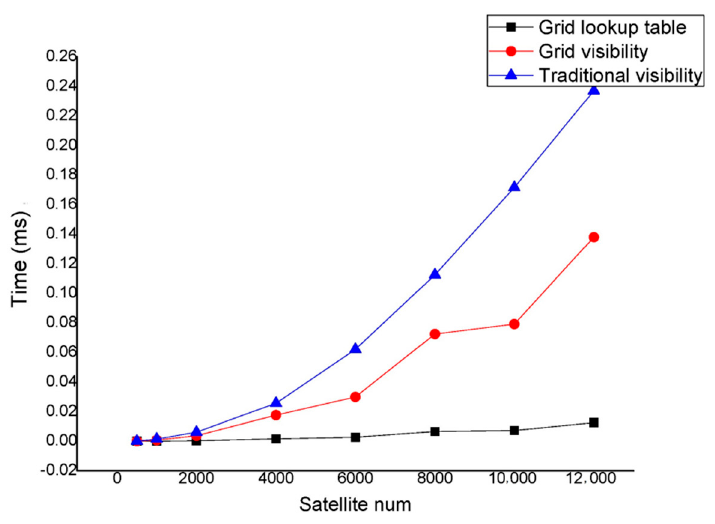
Figure 10. Comparison of visibility calculation efficiency. Table 4. Visibility calculation results (ms).